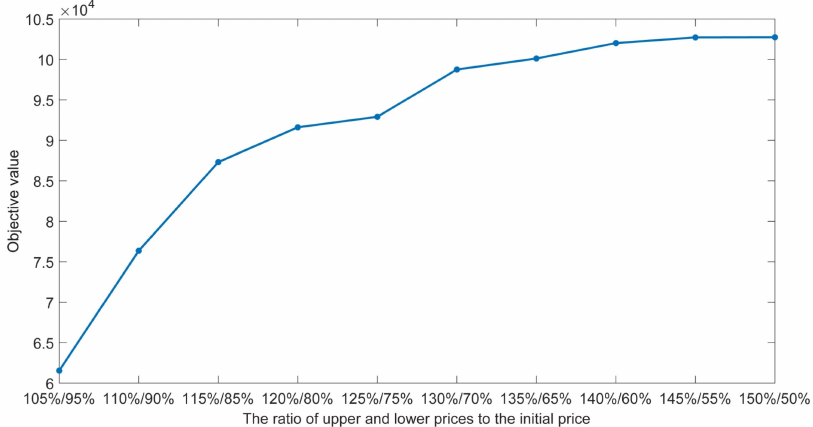
Figure 9. Variation curve of the objective function with different upper and lower price